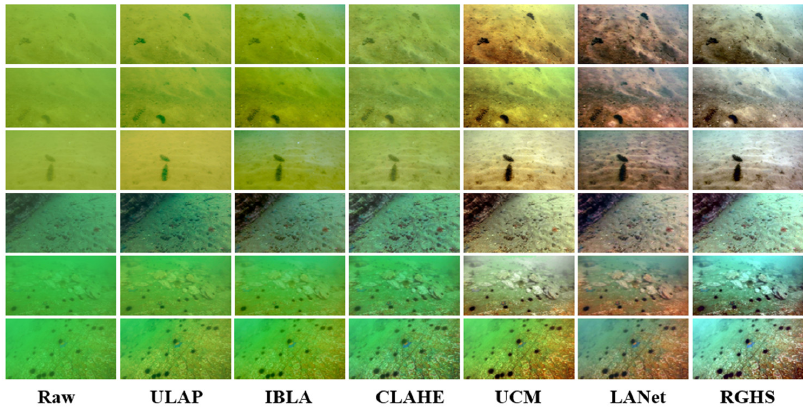
Figure 5. Experimental comparison of enhancement performance on underwater images. Table 1. Performance comparison of image enhancement module. Model